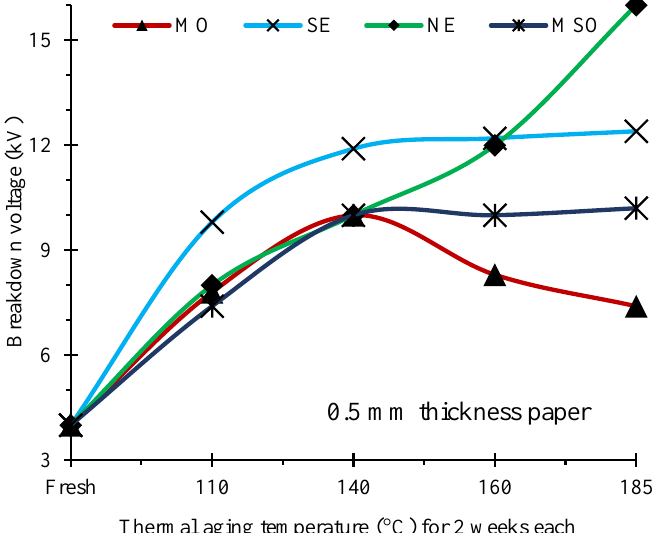
Figure 10. Change in paper BDV with the diffusion of various insulating oils for 0.5 mm thickness papers with thermal stresses.